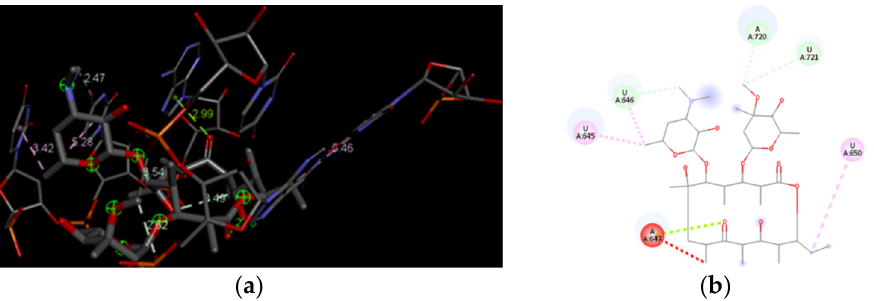
Figure 7. ( a ) Graphical representation of the obtained interactions between 8- d -erythromycin B and the segment of the exit tunnel from apicoplast ribosome of P. falciparum with distances in Å; ( b ) 2D diagram of receptor–ligand interactions.